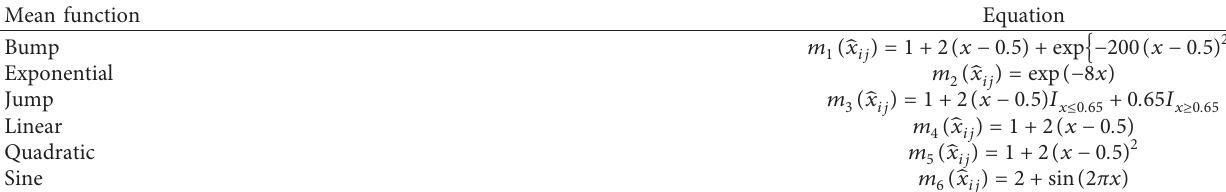
Table 1: Mean functions simulated.